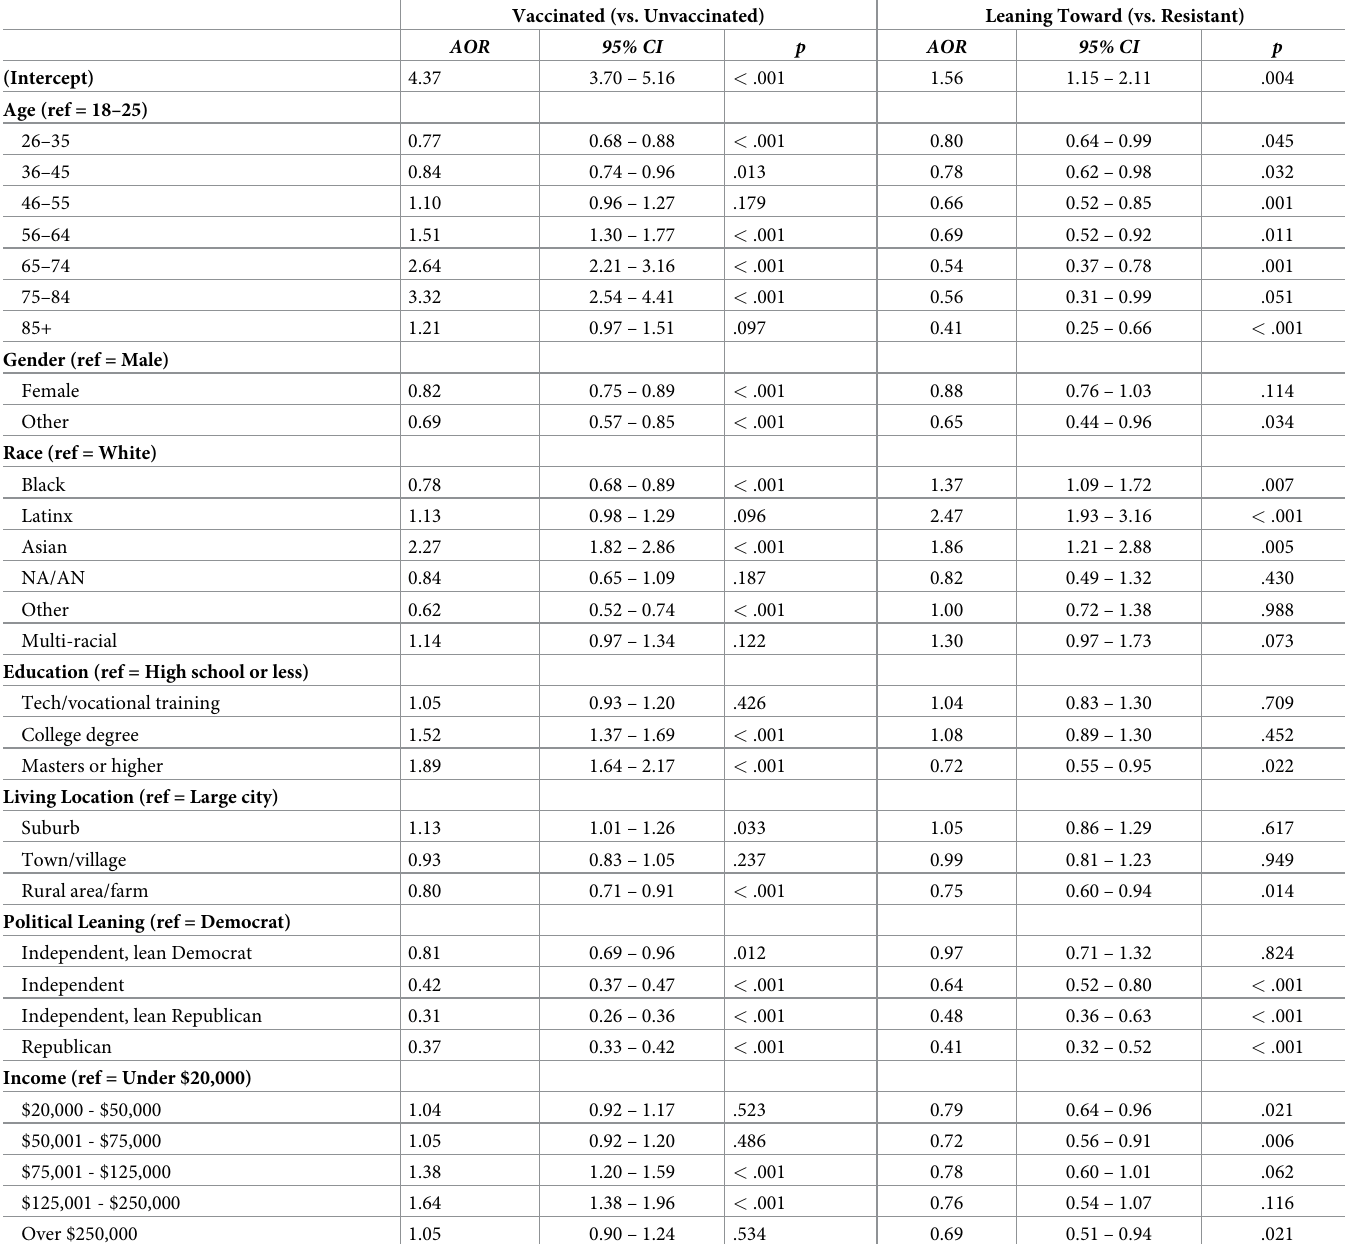
Table 2. Multiple logistic regression analyses predicting vaccination status and intention (dichotomized) by demographics. Vaccinated (vs.